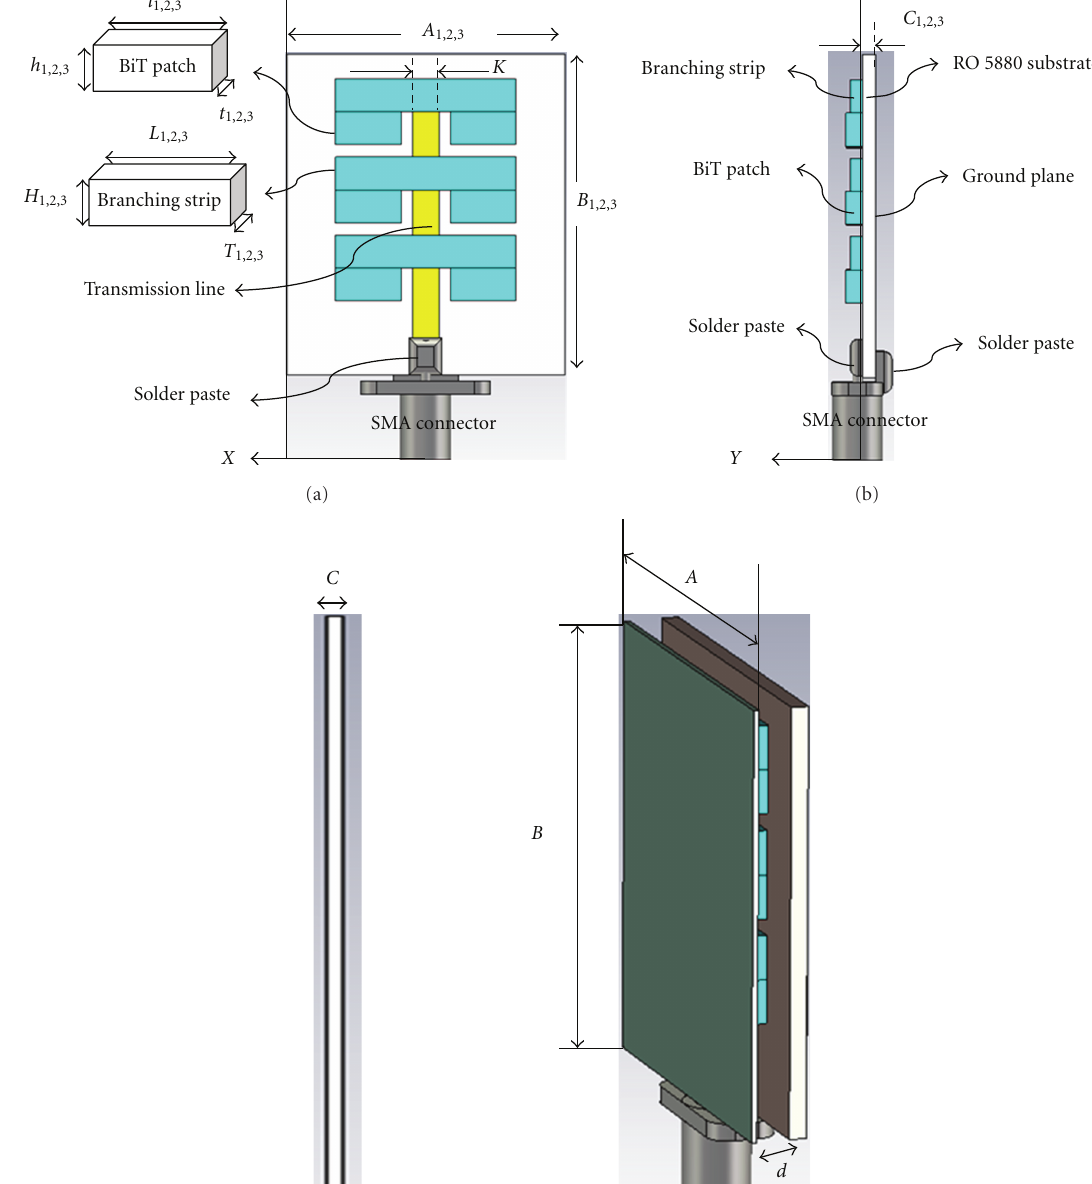
optimized to K = 4 . 6 mm in order to achieve the best 50 Ω input impedance